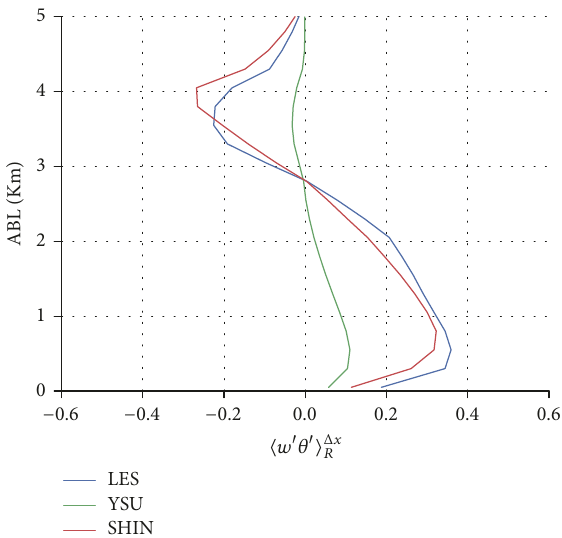
Figure 11: Vertical profiles of domain-averaged resolved vertical heat transport.